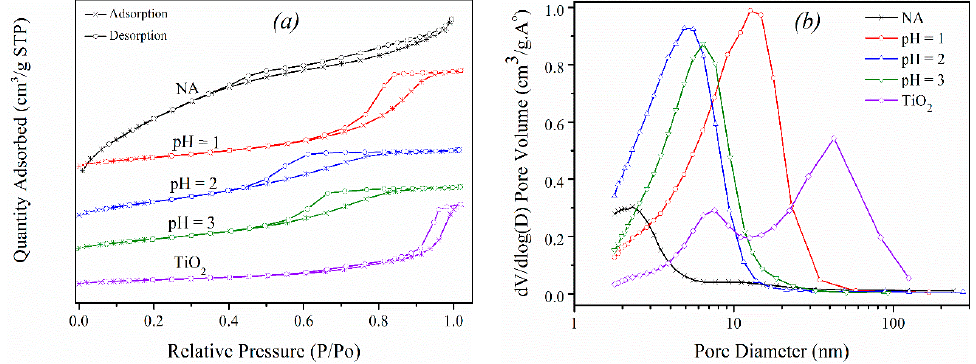
Figure 1. Characterization of BFS ‐ TiO 2 and TiO 2 supports: ( a ) isotherms of N 2 adsorption and desorption; and ( b ) pore size distribution. Table 2. Structural parameters of supports and loading amount of active components for their catalysts.